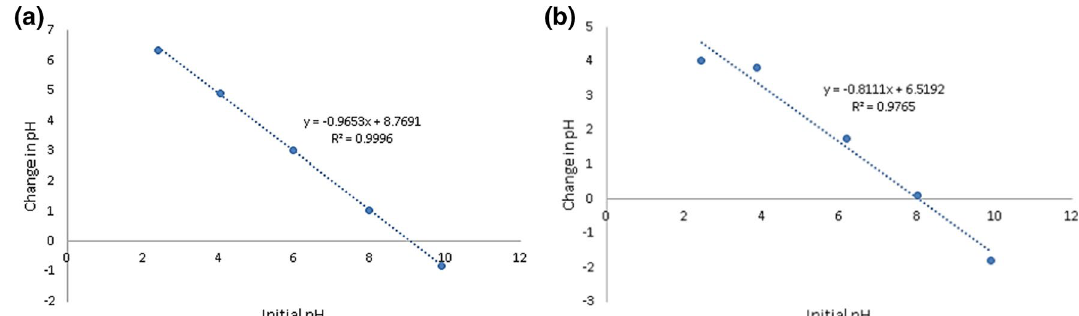
Fig. 9 PZC plots for a MgFZBFA, b